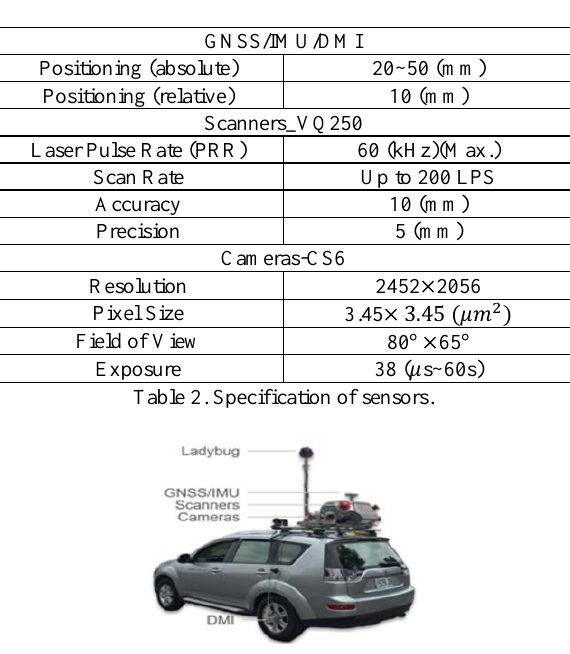
Figure 8. The equipment of commercial MLS